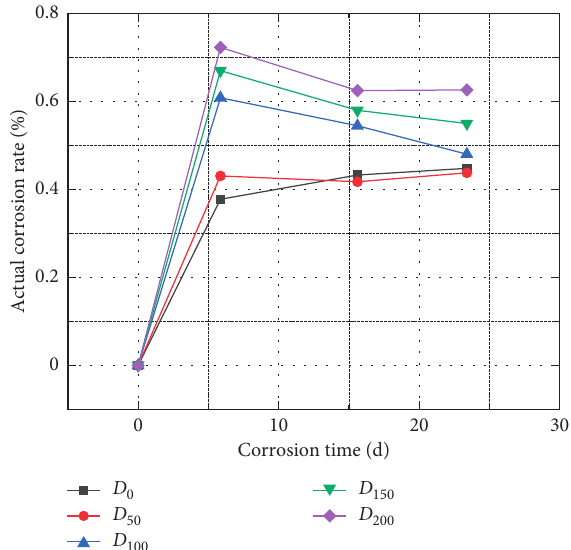
Figure 6: The change of corrosion rate in different corrosion